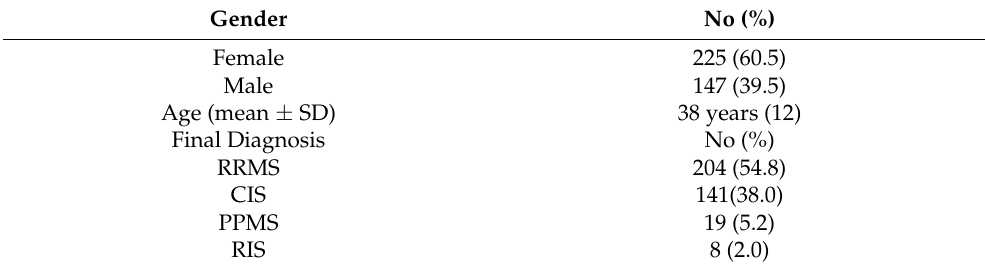
Table 1. Clinical and demographic characteristics of all 372 patients.